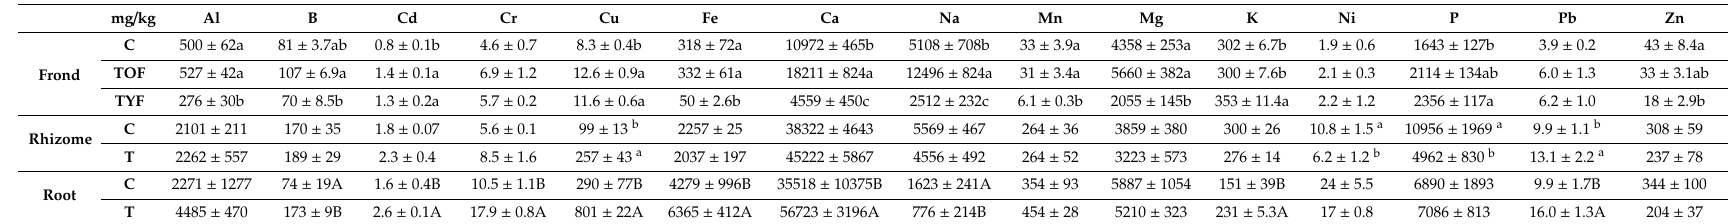
Table 1. Chemical element concentration in Pteris vittata L. plants treated (T) or not (C) for 9 weeks with 28 mgL − 1 Na 2 HAsO 4 · 7H 2 O under hydroponic conditions in greenhouse (TOF, treated old fronds; TYF, treated young fronds). In each column, mean values ( n = 5 ± SE) are reported. One-way ANOVA was applied to analyze mean data in root, rhizome, and frond, respectively. Separation of means was performed by Tukey’s test (di ff erent letters indicate significant di ff erence at p ≤ 0.05; In each column and within each organ, letters of significance were assigned as follows: small letter, frond; superscript letters, rhizome; capital letters,